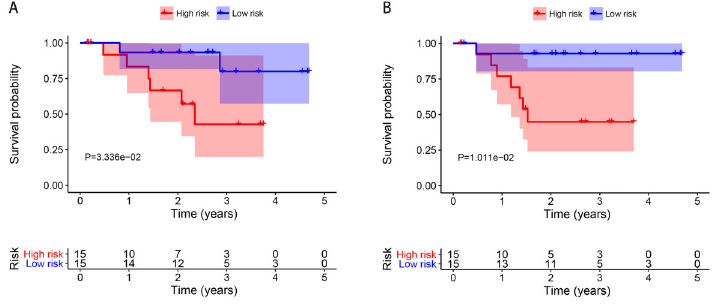
Figure 4. Kaplan-Meier curve for ( A ) disease-speci fi c survival (DSS) and ( B ) progression-free survival (PFS) in the high-risk and low- risk head and neck carcinomas (HNC) patients when strati fi ed by the risk score. Low-risk group patients had higher survival probabilities than those in the high-risk group (P=0.033 and P=0.010, respectively).